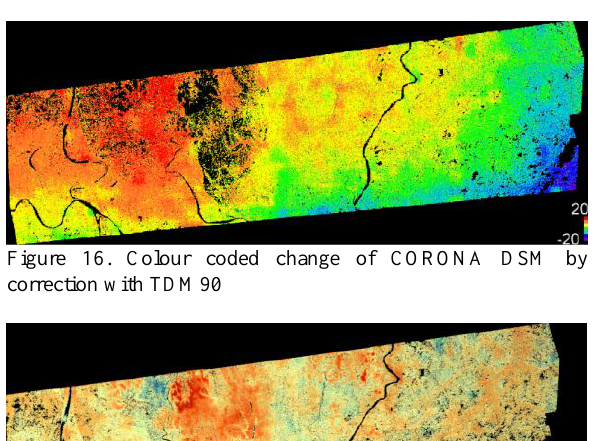
Figure 15. Colour coded height differences CORONA DSM against TDM90